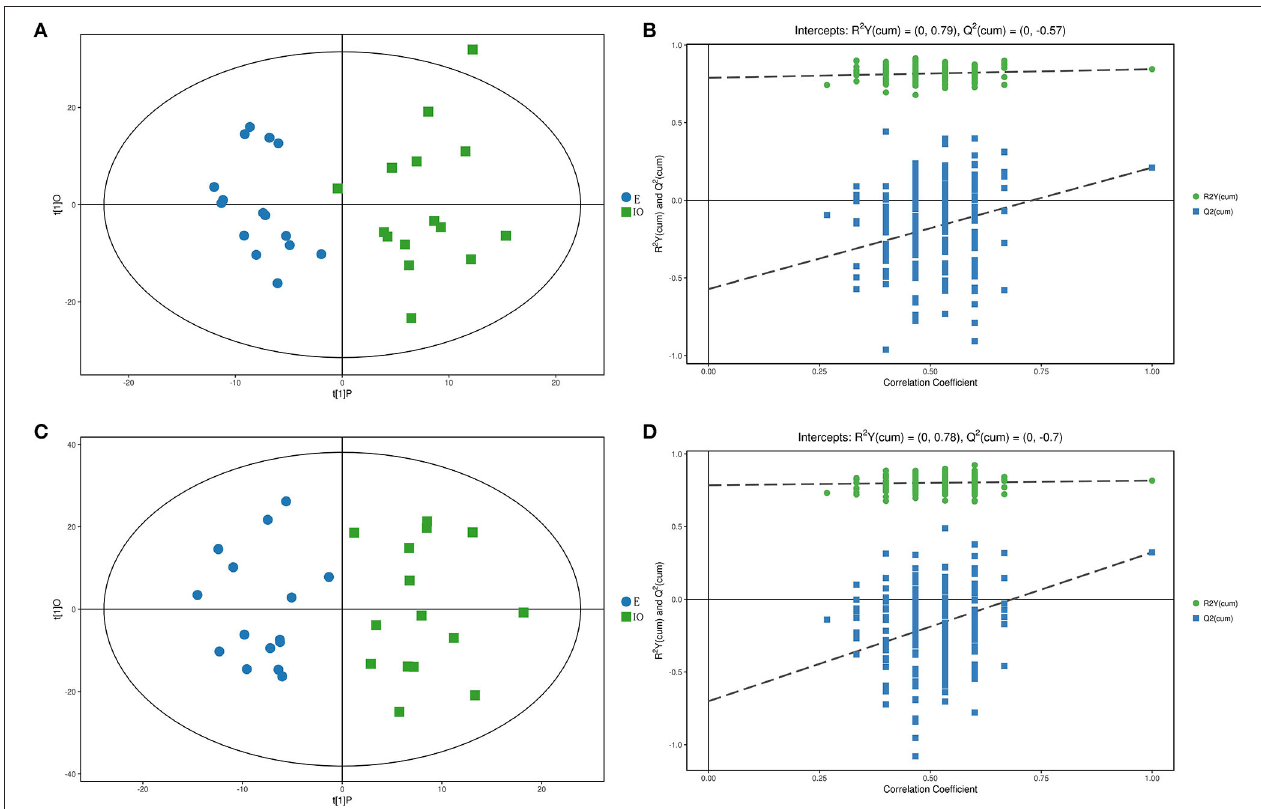
FIGURE 3 | Score scatterplot and permutation test of the OPLS-DA model for the E (blue) vs. IO (green) group. (A,B) shows the results in ESI( + ). (C,D) shows the results in ESI(–). (A,C) is a scatterplot. The abscissa represents the predicted score of the first principal component, the ordinate represents the orthogonal principal component score, and the scatter colors represent different experiments groups. (B,D) is the result of the displacement test. The abscissa indicates the displacement retention, the ordinate indicates the value of R 2 Y or Q 2 , the green dot indicates the R 2 Y value, the blue square indicates the Q 2 value, and the dotted line indicates the regression